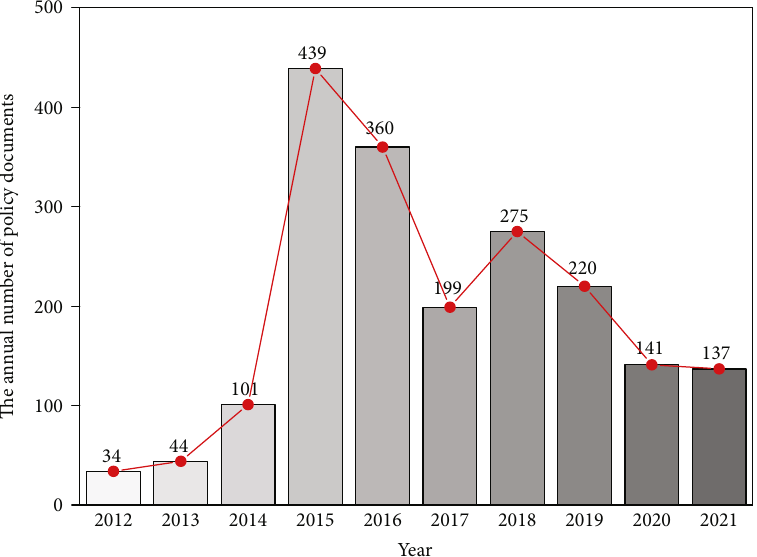
Figure 2: The annual number of policy documents about “ innovation and entrepreneurship ” in the Chinese government o ffi cial website from 2012 to